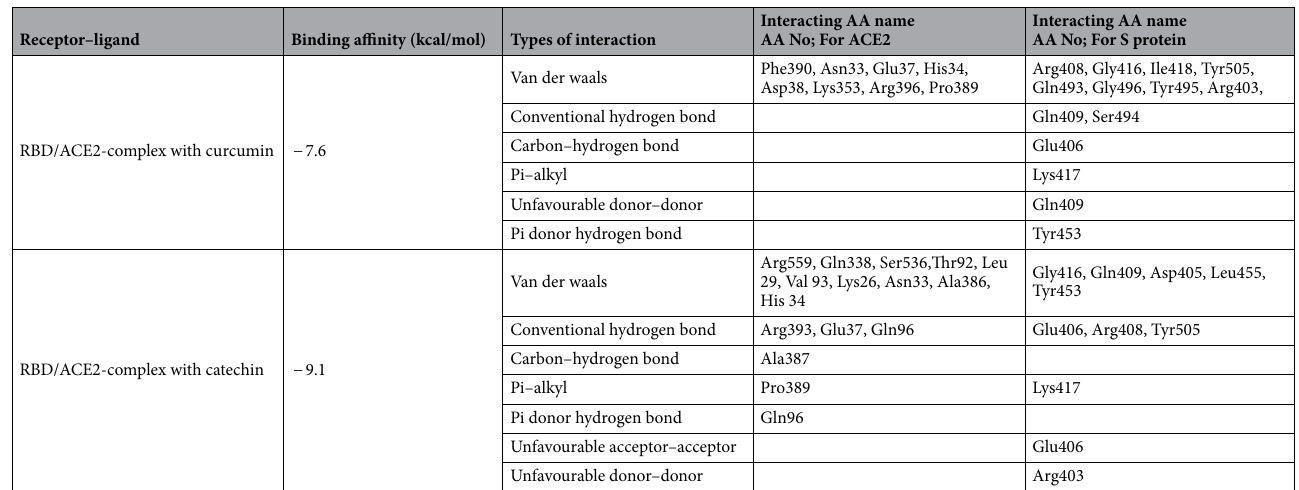
Receptor–ligand Binding affinity (kcal/mol) Types of interaction